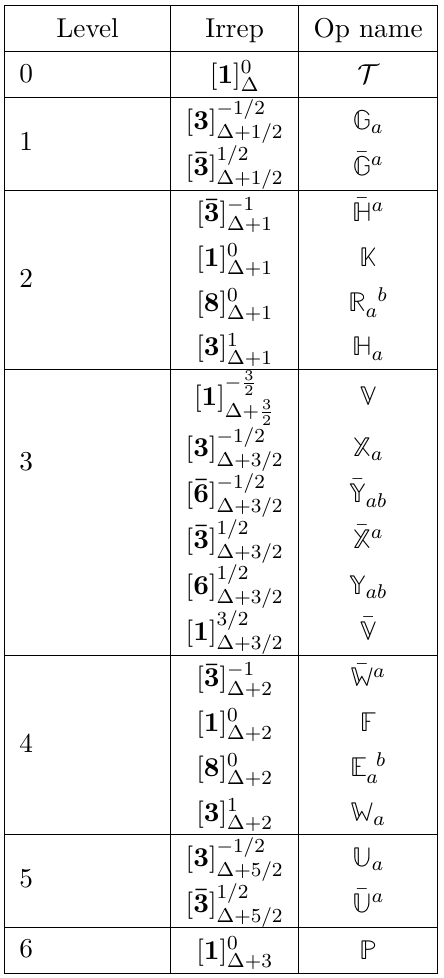
Table 1. The list of operators in the T supermultiplet with their quantum numbers. We use the notation [ A ] m , where A is the irrep of SU(3), ∆ the scaling dimension, and m the eigenvalue of ∆ the U(1) generator